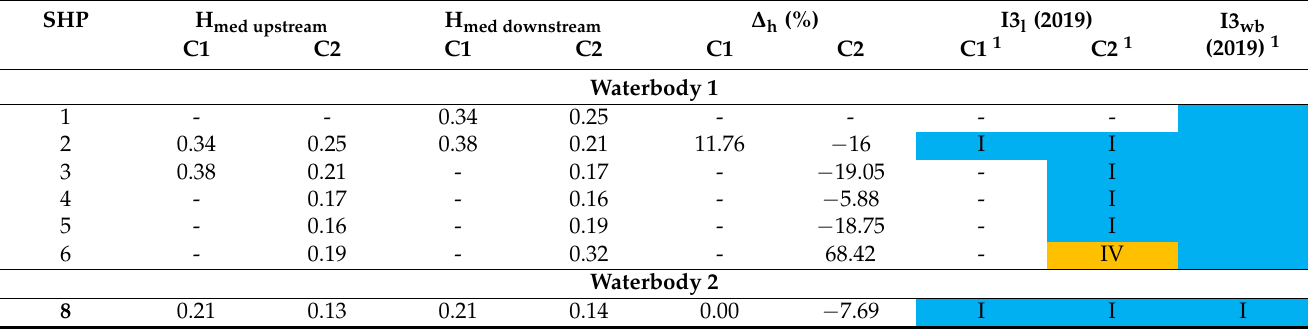
Table 7. The results of the indicator mean water depth variation (local and waterbody level).